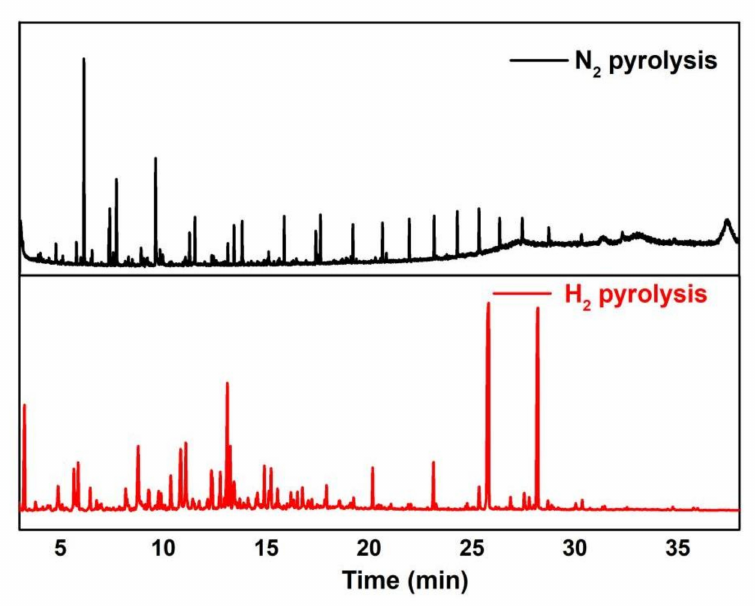
Figure 6. GC-MS analysis of the pyrolysis bio-oils under different